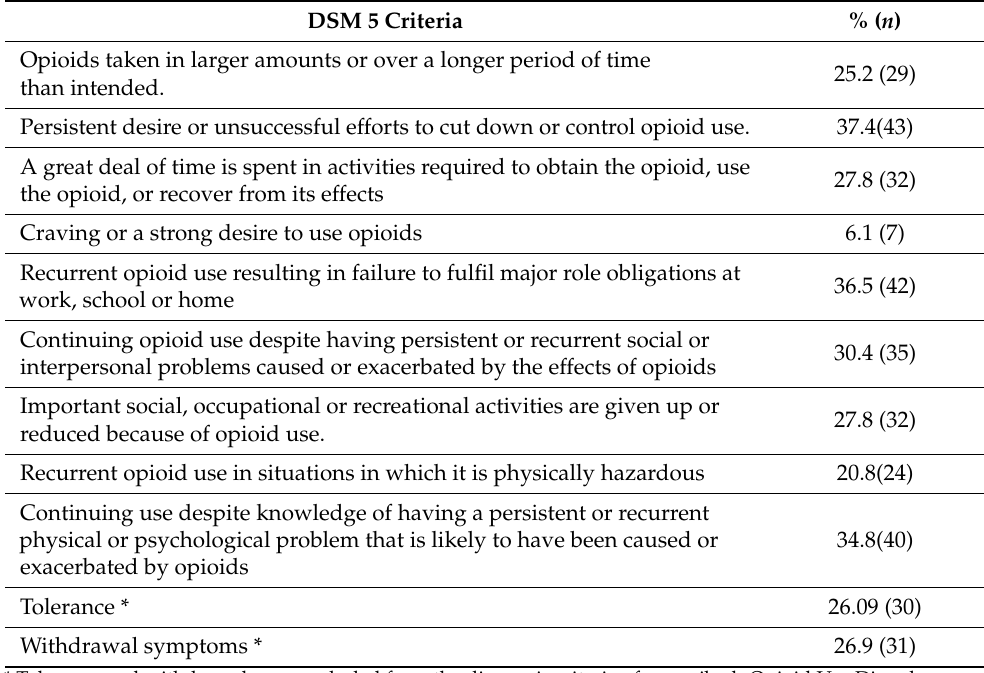
Table 3. Frequency of the Diagnostic and Statistical Manual of Mental Disorders 5 (DSM 5) criteria for opioid use disorder (OUD) in the population ( n = 115). DSM 5 Criteria % ( n ) 25.2